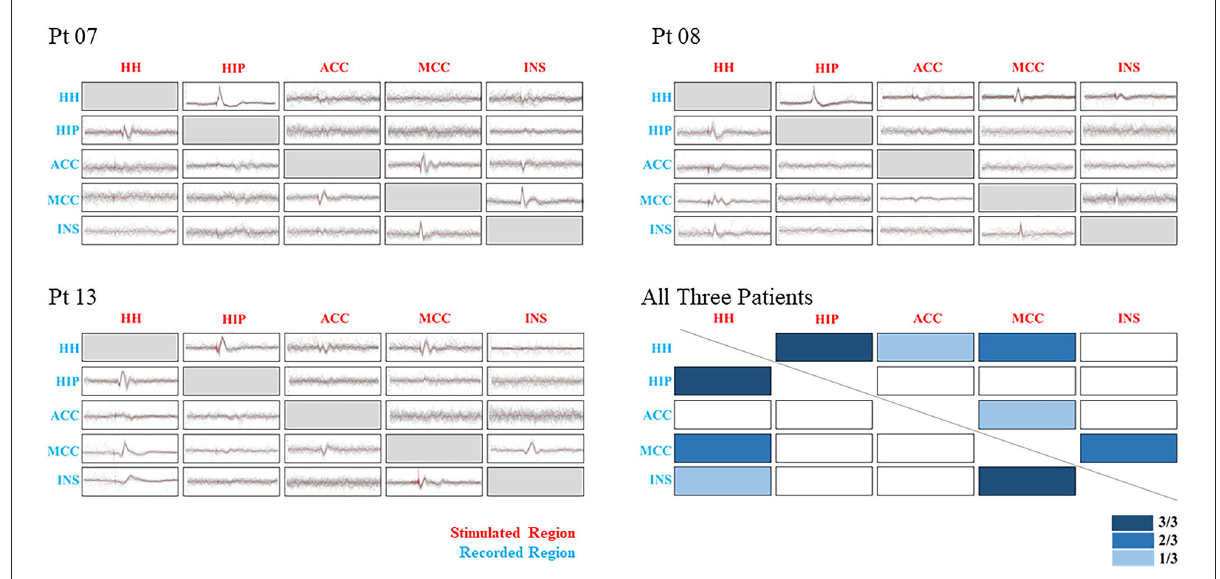
FIGURE4 Showing CCEP results of three patients and their combining results. Five regions were selected to be shown in different ranks by stimulated and recorded conditions. The x -axis stands for the stimulated regions, and the y -axis stands for the recorded regions. Three degrees of the color bar were used to show the different combining results, with a darker bar corresponded to a higher positive rate. Pathological relationships were observed between HH-HIP, MCC-INS, and HH-MCC. CCEP, cortico-cortical evoked potentials; HH, hypothalamic hamartoma; HIP, hippocampus; ACC, anterior cingulate cortex; MCC, middle cingulate cortex; INS, insular